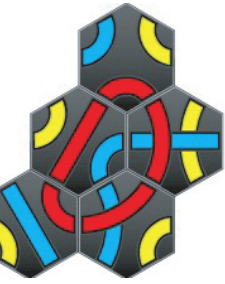
Figure 3. An example of a “cleared” arrangement; a Tantrix solution of challenge number 5.